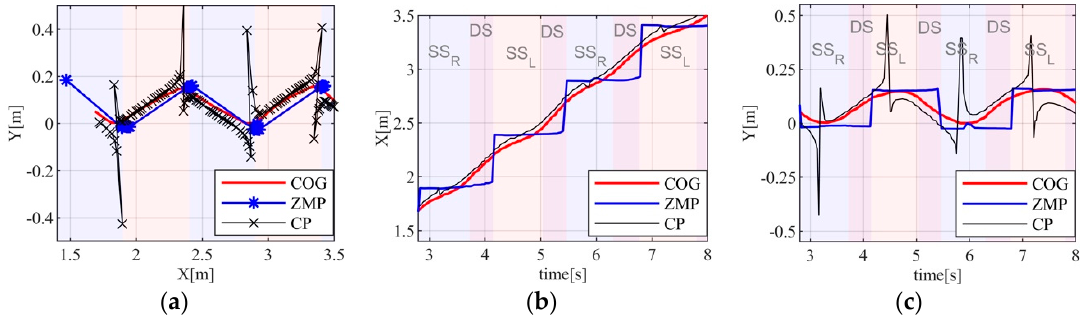
Figure 7. Results of stability indices and CP which are detected from the human walking (red line: COG, blue line: ZMP, and black line: CP): ( a ) Traces of stability indices and the CP in the xy -axis; ( b ) results of stability indices in x -axis (walking forward); ( c ) results of stability indices and the CP in y -axis (toward left and right).